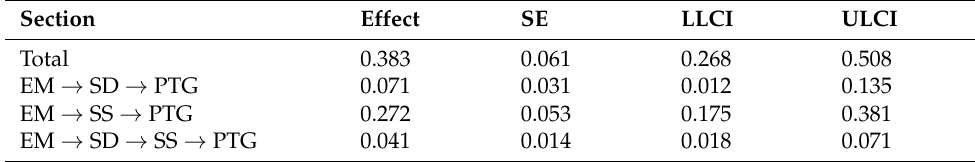
Table 4. The chain mediating effect of self-disclosure and social